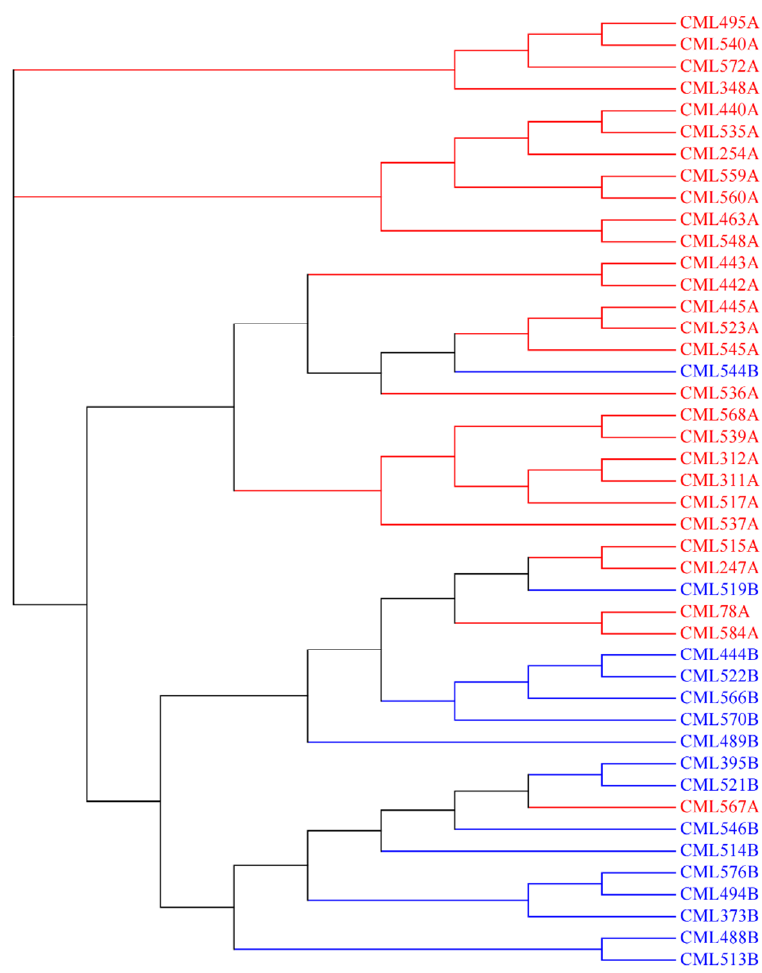
Figure 7. Neighbor-Joining tree based on IBS’ genetic distance for the 44 key founder CMLs of the East Africa (EA) maize breeding program. CMLs from heterotic groups A and B are represented by red and blue , respectively.